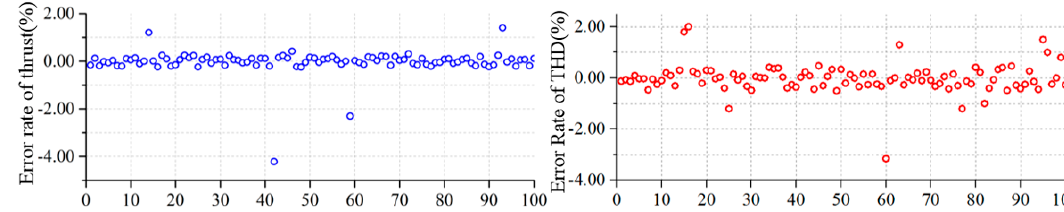
Figure 7. Error rate of multi-SVM: ( a ) error rate of thrust (%); and ( b ) error rate of THD (%).